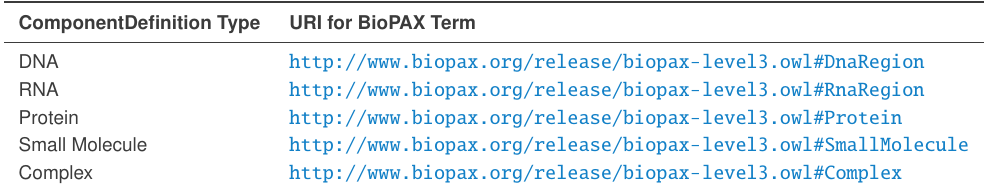
Table 2: BioPAX terms to specify the molecule type using the types property of a ComponentDefinition .